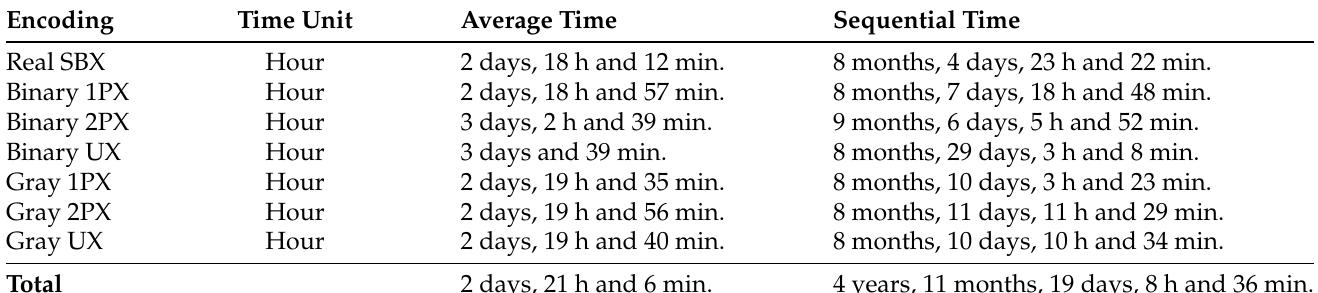
Table 3. Computational time consumed.